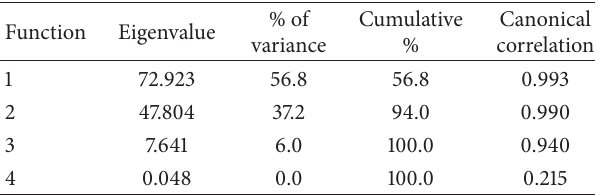
Table 2: The first 4 canonical discriminant functions used in the analysis.